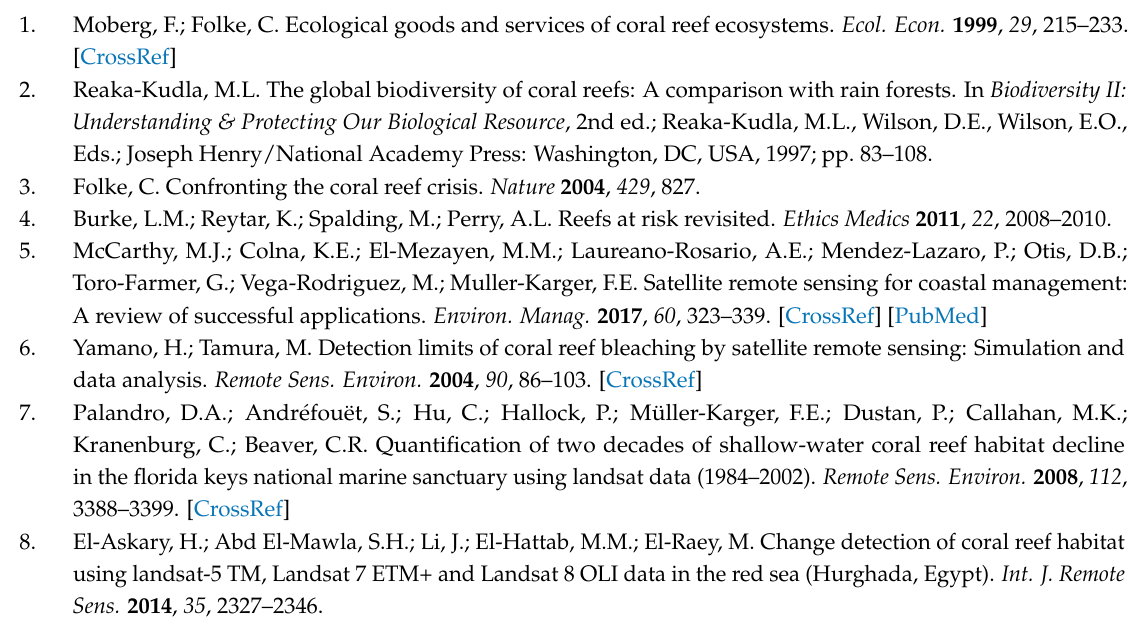
Table A7. The pixel sample numbers of all change categories in Barque Canada Reef. Change Categories